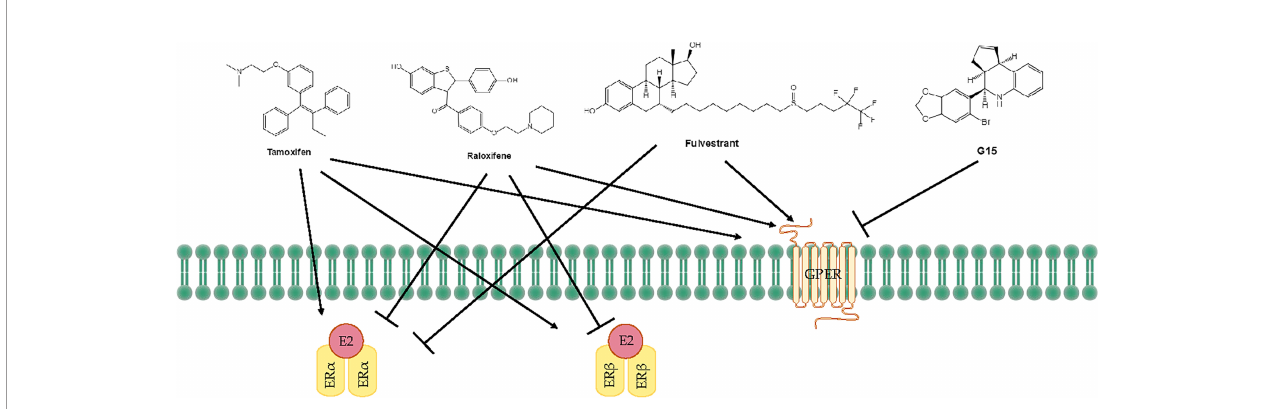
FIGURE 3 | Treatments for endometrial diseases. ER, estrogen receptor; GPER, G-protein-coupled estrogen receptor; EGFR, epidermal growth factor receptor; ERE, estrogen response element; MMP, matrix metallopeptidase; LBD, ligand-binding domain; P,